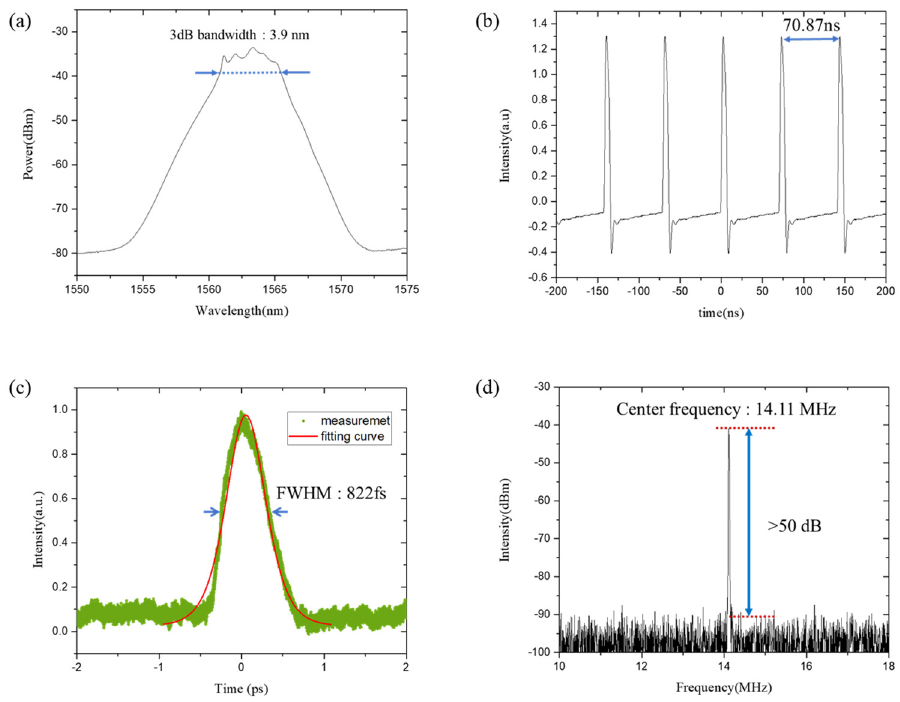
Figure 4. Soliton pulse train of the 1.5 µm passively mode-locked fiber laser: ( a ) optical spectrum; ( b ) oscilloscope trace; ( c ) autocorrelation trace; ( d ) RF ( b ) oscilloscope trace; ( c ) autocorrelation trace; ( d ) RF spectrum.